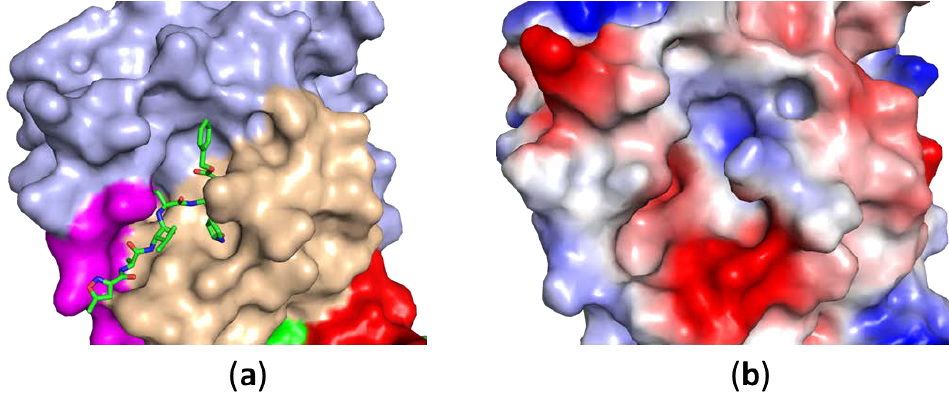
Figure 4. The substrate binding site of SARS-CoV-2 3CL pro . ( a ) A cocrystal structure of SARS-CoV-2 3CL pro with an inhibitor (N3) is shown. ( b ) Surface charge analysis of the active site of the protease. The structure (PDB ID 6LU7) is shown using PyMOL (https://pymol.org/2/). The protease in the absence ( a ) and presence ( b ) is shown in the same orientation. The inhibitor is shown as green sticks. Only domains I and II of one protomer of the protease is shown for clarity.